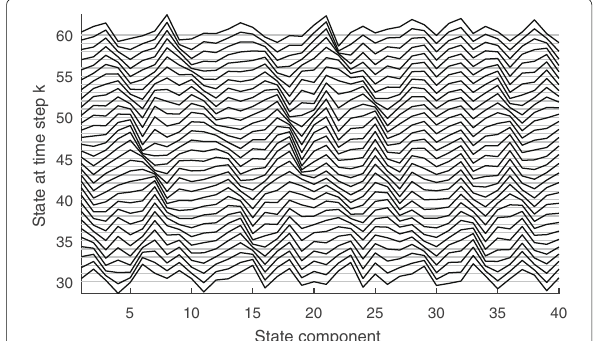
Fig. 15 State evolution for the Lorenz model. Each horizontalline carries a 40-dimensional state